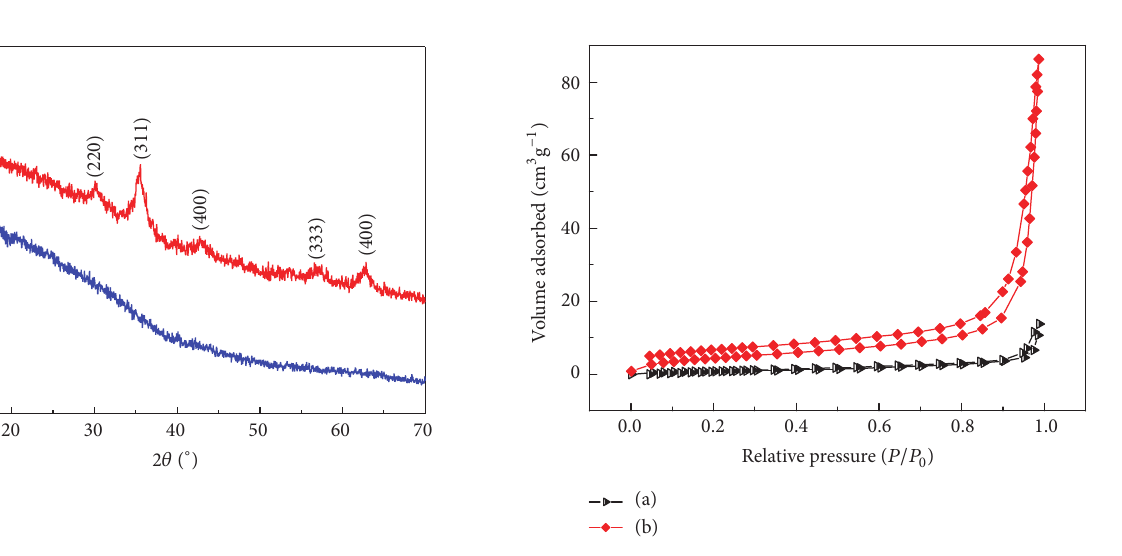
Figure 5: Nitrogen sorption isotherm of (a) Fe(OH) 3 @PMMA composite microspheres and (b) magnetic